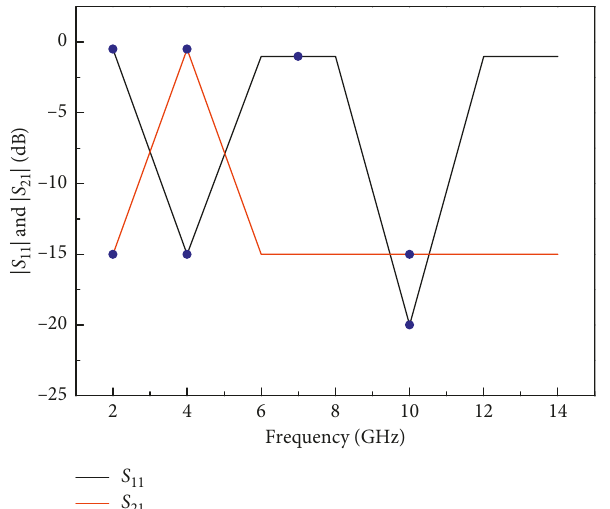
Figure 8: The desired frequency response of | S FSS in the passband and absorption band.